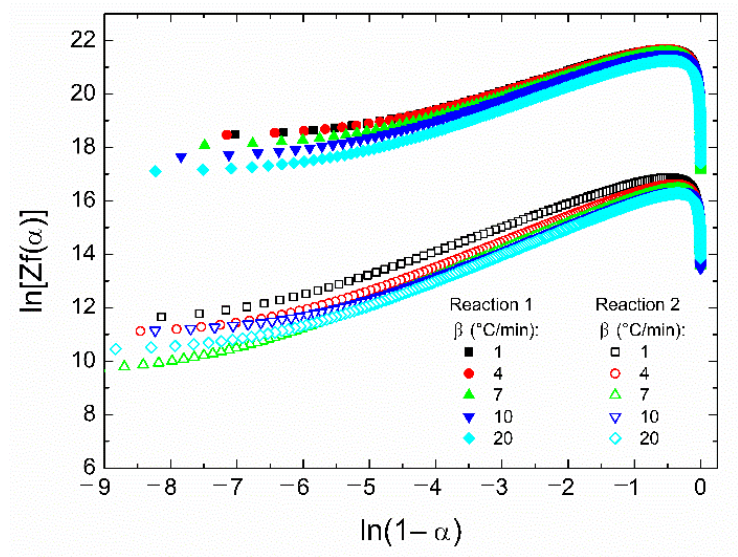
Figure 8. Plots of ln[ Zf ( α )] vs. ln(1 − α ) for reactions 1 and 2 at several heating rates. The average activation energy obtained from the Ozawa method was used.